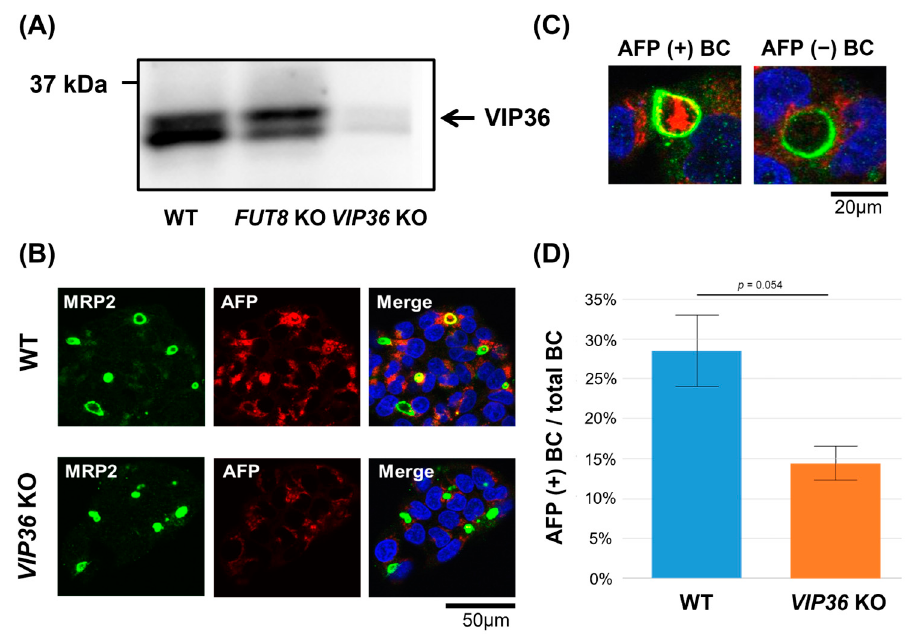
Figure 4. Accumulation of AFP in bile duct-like structures was reduced by VIP36 KO in HepG2 cells. ( A ) Immunoblot of the expression level of VIP36 in VIP36 -KO HepG2 cells compared with WT and FUT8 -KO HepG2 cells. ( B ) Co-staining of WT and VIP36 -KO HepG2 cells with anti-MRP2 (green) and anti-AFP (red) antibodies. Colocalization is displayed in yellow (Merge). Blue is the nuclear stain using 4 ′ ,6-diamidino-2-phenylindole. ( C ) Representative images of bile duct-like structures formed on HepG2 cells and stained with anti-AFP (red) and anti-MRP2 (green) antibodies. ( D ) The percentage of anti-AFP antibody and anti-MRP2 antibody co-positive cells in 30 randomly selected visual fields from images of WT and VIP36 -KO HepG2 cells. BC: bile canaliculus (bile duct-like structure). Results are expressed as the mean +/ − SD.